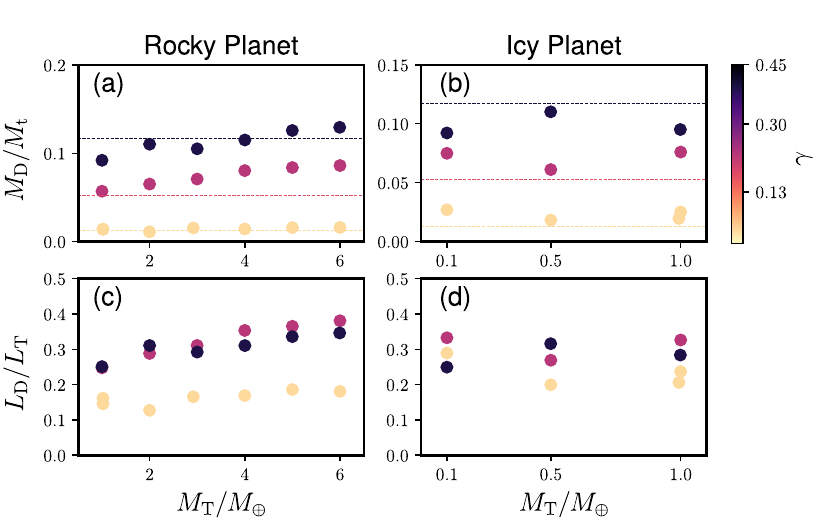
Fig. 2 Disk masses and angular momenta based on our SPH simulations. a , b The disk mass M D normalized by the target mass M t as a function of the total mass M T normalized by the Earth mass for rocky and icy planets, respectively. The colors represent the values of γ . The dashed lines represent the disk mass estimate from previous work assuming a rocky composition 25 . c , d The disk angular momentum L D normalized by the total angular momentum for rocky and icy planets L T ,